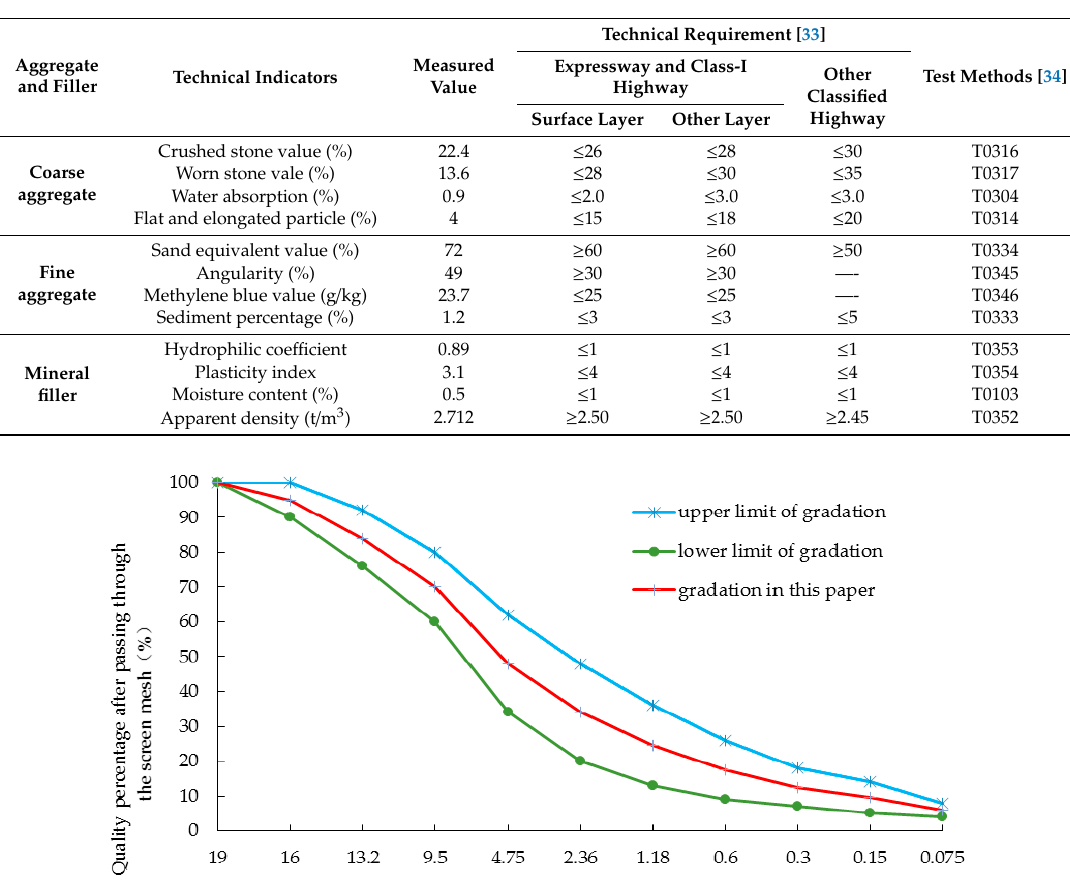
Table 2. Technical indicators of aggregate and filler.